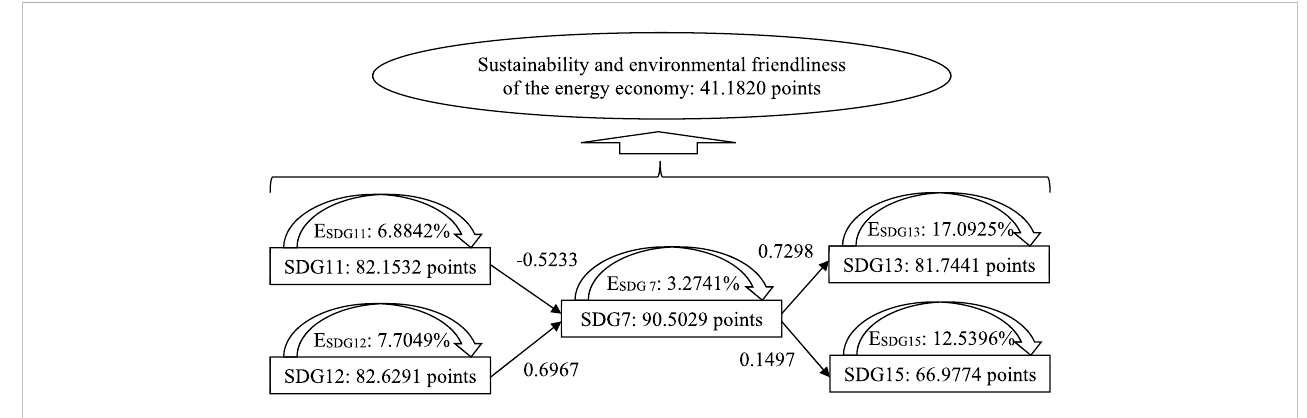
FIGURE 1 A case example of monitoring of the sustainable and environmentally friendly development of the energy economy in the EAEU